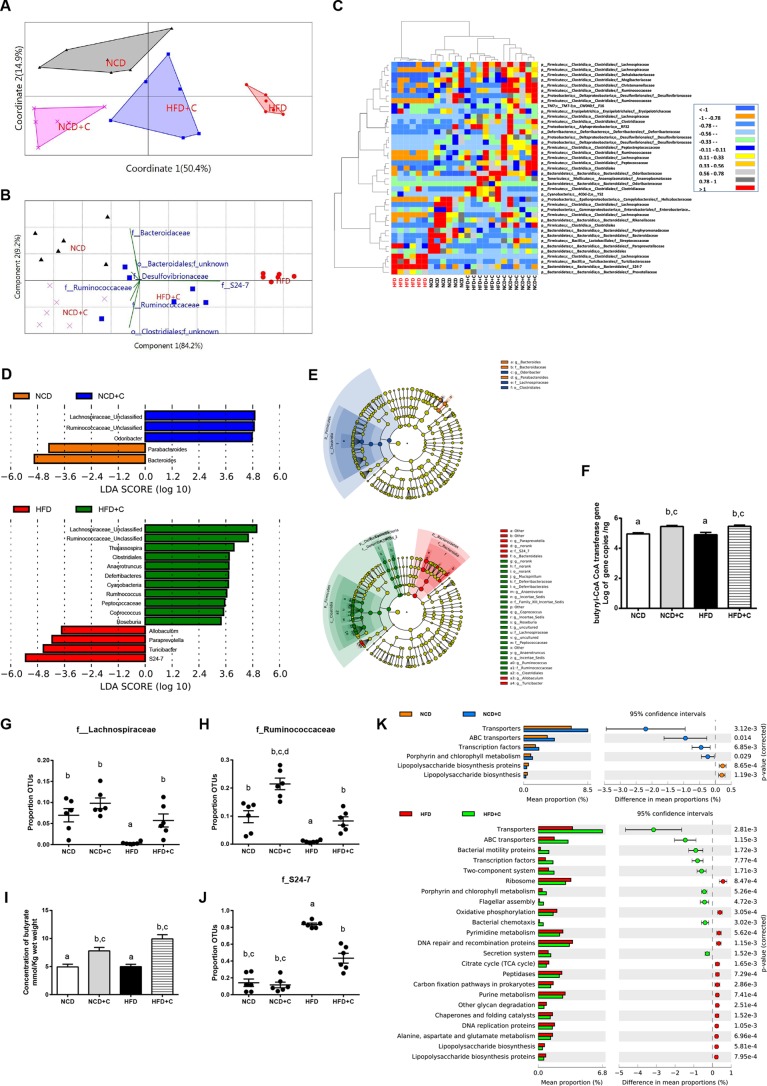
Dietary CAP beneficially alters the gut microbiota. Male WT mice (n = 6/group) were fed either NCD±C or HFD±C for 12 weeks. Cecal contents were subjected to 16S rRNA gene sequencing and qPCR analysis. (A) Principal-coordinate analysis based on the Bray-Curtis similarity index with the PERMANOVA significance test. (B) Similarity percentage (SIMPER) analysis, which was used to identify the specific genera with the greatest contribution to the differences observed between the groups, followed by principal-component analysis (variance-covariance type) showing the top 7 operational taxonomic unit (OTU) scores included as vectors. The magnitude and direction correspond to the weights. (C) Hierarchical clustering with a heat map shows the relative abundance of representative OTUs (those with greatest difference between the HFD and HFD+C group means from each family) selected for P < 0.05, obtained with differential expression analysis of the four groups. The OTUs are shown as phylum, class, order, and family. (D) Linear discriminant analysis (LDA) scores derived from LEfSe analysis, showing the biomarker taxa (LDA score of >2 and a significance of P < 0.05 determined by the Wilcoxon signed-rank test). (E) Cladogram generated from LEfSe analysis showing the relationship between taxon (the levels represent, from the inner to outer rings, phylum, class, order, family, and genus). (F) Abundance of butyryl-CoA transferase (BCoAT) genes. (G and H) Relative abundance (RA) of short-chain fatty acid (SCFA)-producing families Lachnospiraceae (G) and Ruminococcaceae (H). (I) Fecal concentration of butyrate SCFA. (J) RA of members of the Gram-negative LPS-producing family S24-7. Data are expressed as means ± SEM. Data with different superscript letters are significantly different (P < 0.05) by one-way ANOVA with a post hoc Bonferroni’s multiple-comparison test. PICRUSt analysis shows the relative abundance of predicted microbial genes related to metabolism for four different groups based on Welch’s t test (P < 0.05). The colored circles represent 95% confidence intervals calculated using Welch’s inverted method (K).